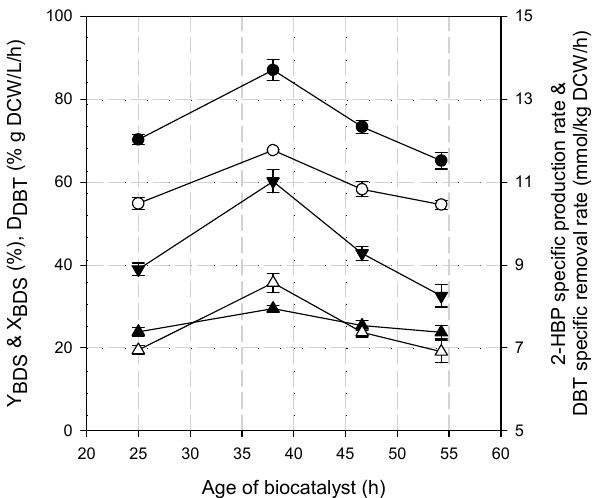
Figure 5. Biodesulfurization of DBT by R. erythropolis IGTS8 resting cells obtained from different stages of growth. Symbols : ( λ ) Y BDS (%), ( ◯ ) X BDS (%), ( π ) D DBT (% g DCW/L/h), ( △ ) specific 2-HBP production rate (mmol 2-HBP/kg DCW/h), and ( θ ) specific BDT removal rate (mmol/kg DCW/h).